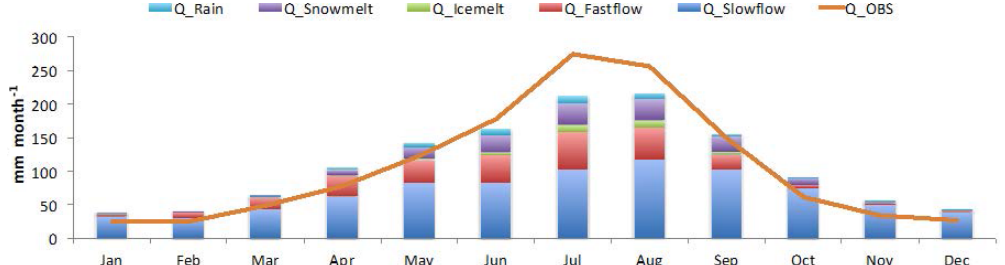
Figure 4. The monthly averages of discharge components and observed discharge (Q_OBS) in the upper Beas basin (1990–2004). The plot shows discharge components from a non-glacier area, i.e., fast flow (Q_Fastflow), slow flow (Q_Slowflow), and discharge components from the glacier-covered area, i.e., rainfall discharge (Q_Rain), snowmelt (Q_Snowmelt), and ice-melt (Q_Icemelt)